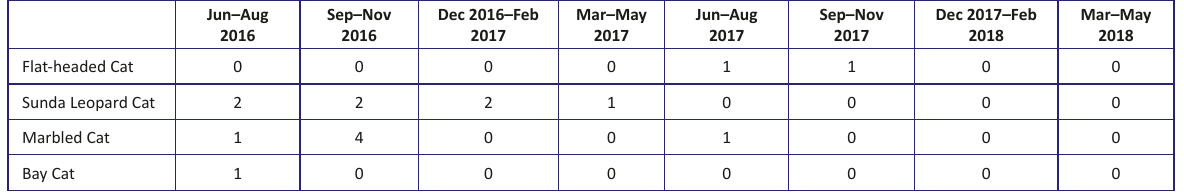
Table 4. Capture rate of small cat species from the inception of the camera trap surveys in Rungan between June 2016 and May